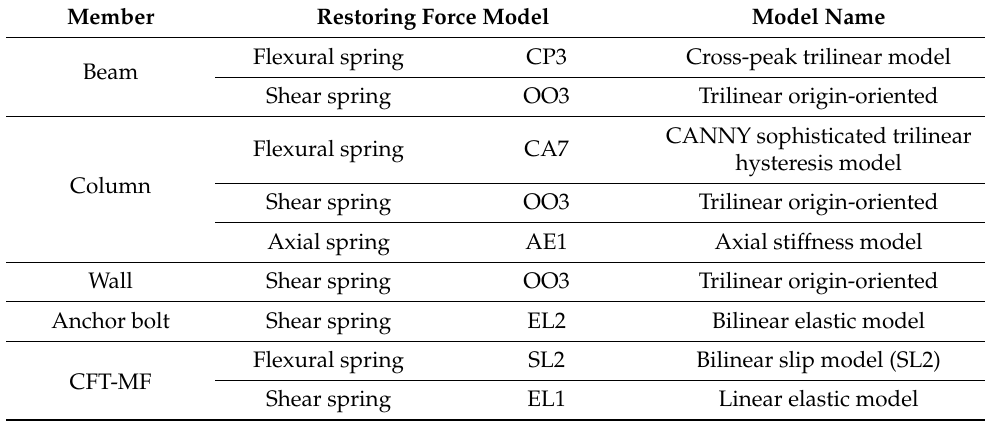
Table 6. Restoring force characteristics of each member used in non-linear dynamic analysis (Li